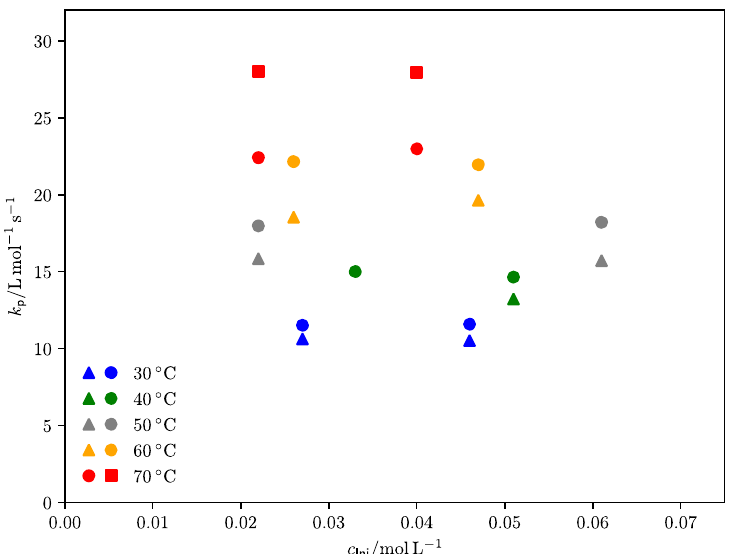
Figure 3. Obtained propagation rate coefficients, k p , for DEI as function of initiator concentration, c Ini . An average of the k p values extracted from the different inflection points is used here. Triangles refer to a laser repetition rate of 0.5 Hz, while circles refer to 1 Hz, and squares to 2 Hz.